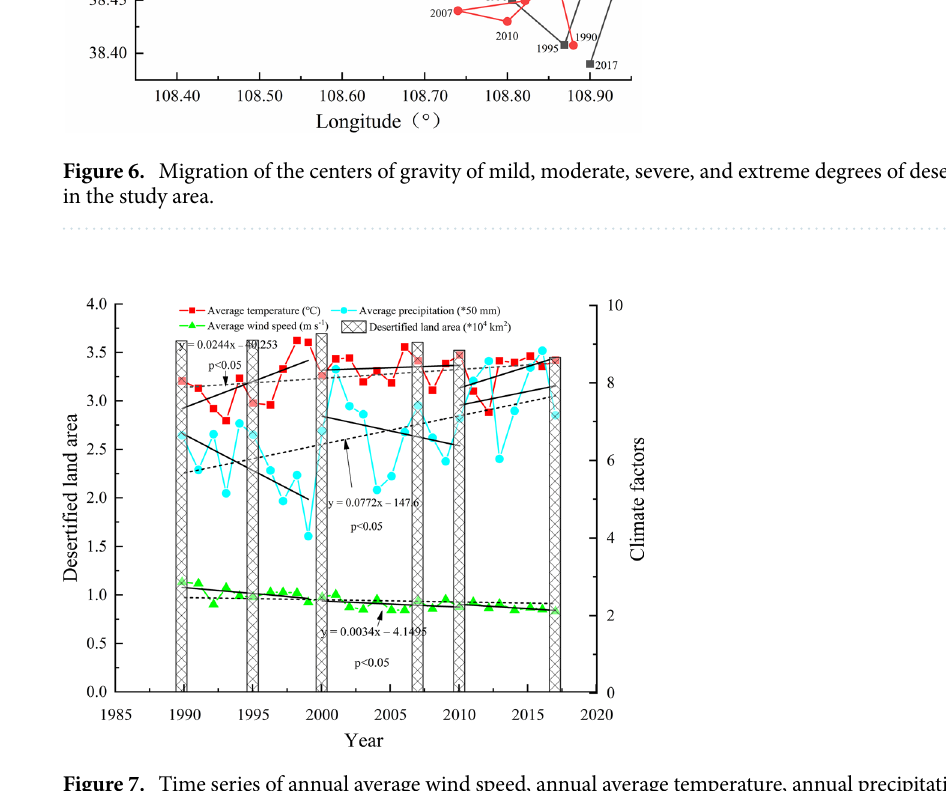
Figure 7. Time series of annual average wind speed, annual average temperature, annual precipitation and desertified land area in the Mu Us Sandy Land from 1990 to